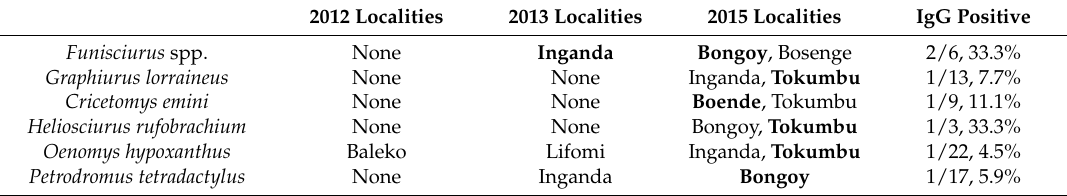
Table 3. Anti-orthopoxvirus immunoglobulin G (IgG)-positive animals by collection year and location, the Democratic Republic of the Congo 2012–2015. Locations in bold represent sites where seropositive animals were collected.